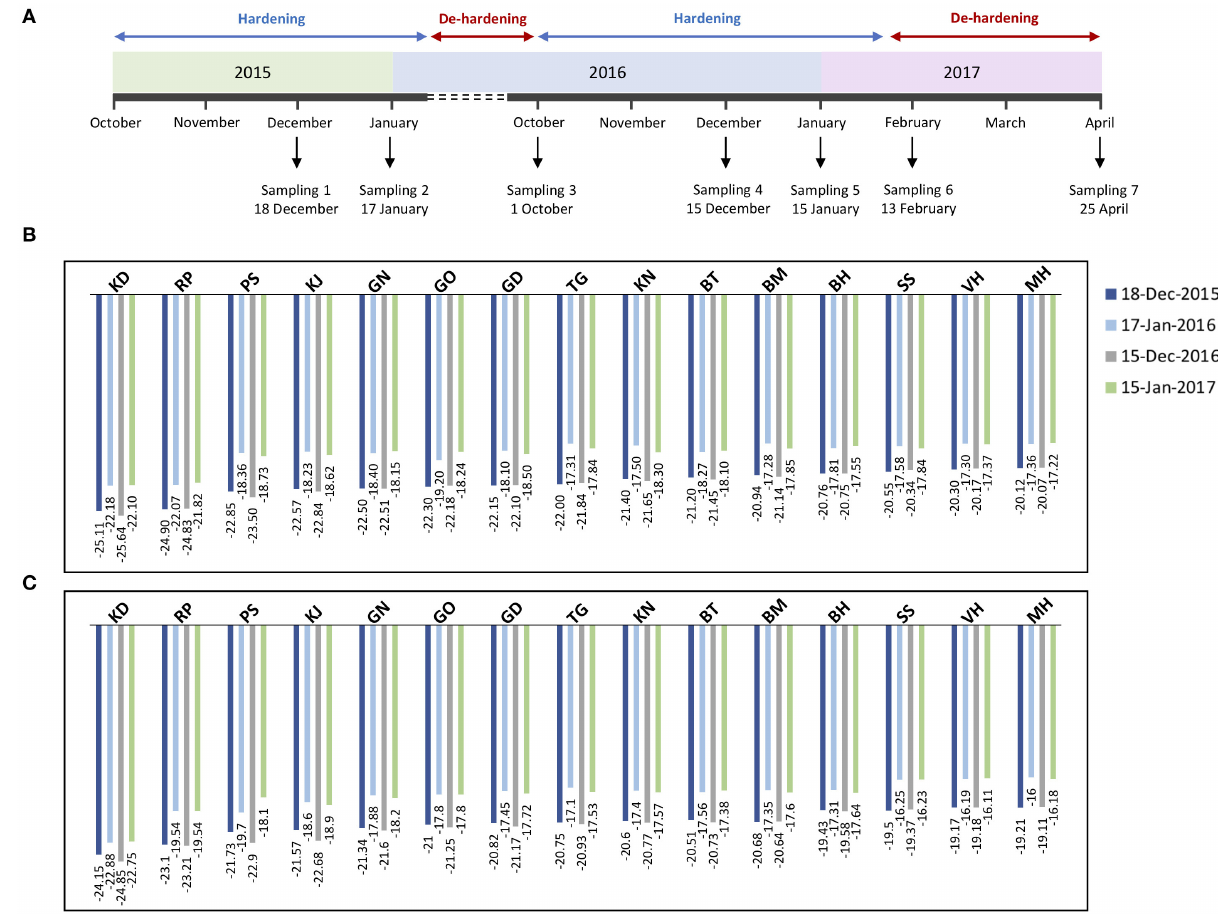
FIGURE 1 | Timeline of sample collection of pomegranate genotypes during two successive developmental cycles (A) . Stem and bud samples were collected at seven time-points (December 18, 2015, January, 17, October, 1 and December 15, 2016, January 15, February 13, and April 25, 2017), in coordination with the timing of the tree hardening/de-hardening cycle. Frost hardiness (expressed as LT50) of the stem (B) and bud (C) of fifteen pomegranate genotypes (KD, RP, PS, KJ, TG, GO, GD, BT, KN, GN, BM, BH, SS, VH, and MH) during December and January of 2 successive